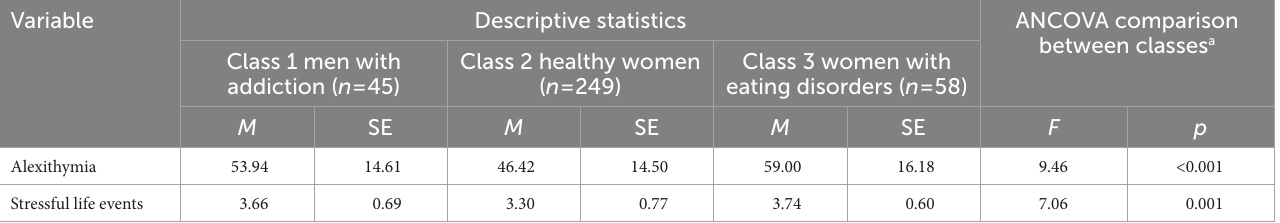
TABLE 4 Alexithymia and stressful life events by classes.